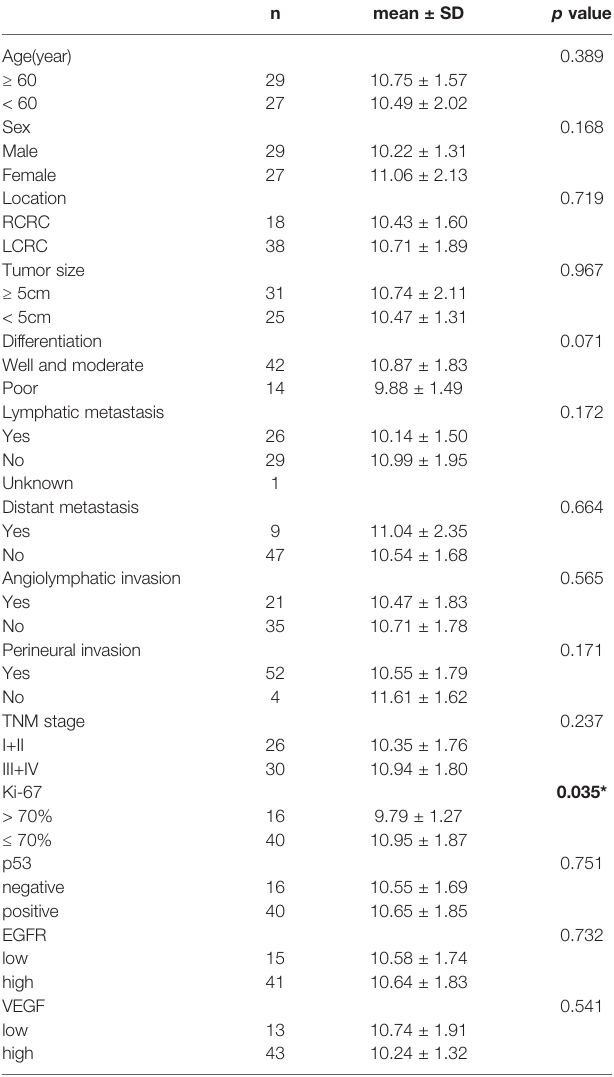
TABLE 4 | Correlation between clinicopathological factors and miR-1539 expression levels in CRC